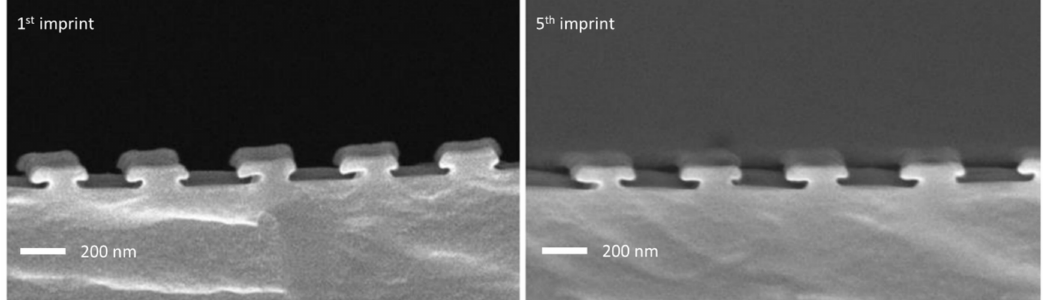
Figure 7. SEM cross-sectional images of the first imprint from (left) the master structure and the fifth imprint (right) using the same